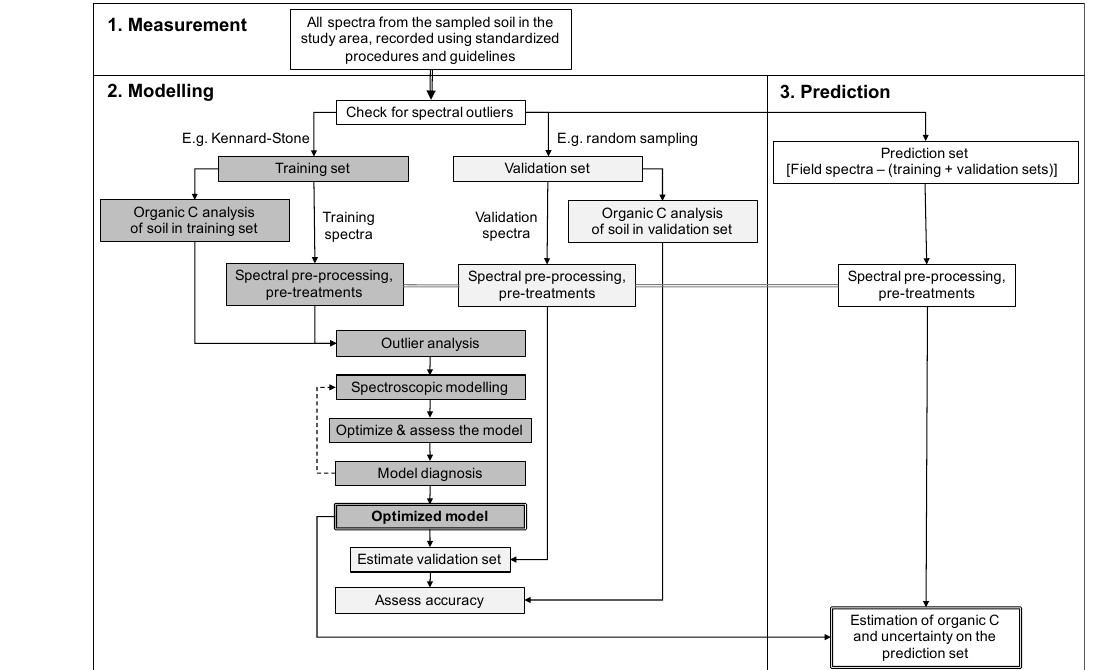
Figure 1. Framework for spectroscopic measurement, modelling, and prediction of soil organic C.